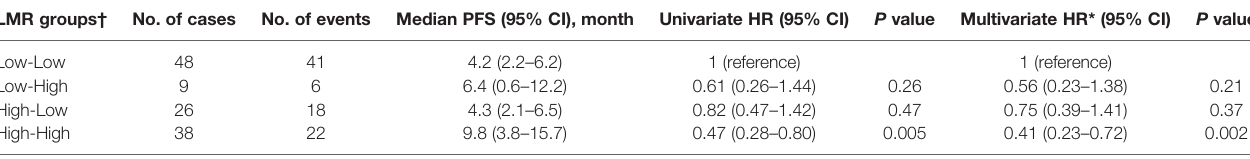
TABLE 3 | Association of changes in LMR with PFS in multivariable Cox regression models of advanced gastric cancer patients.